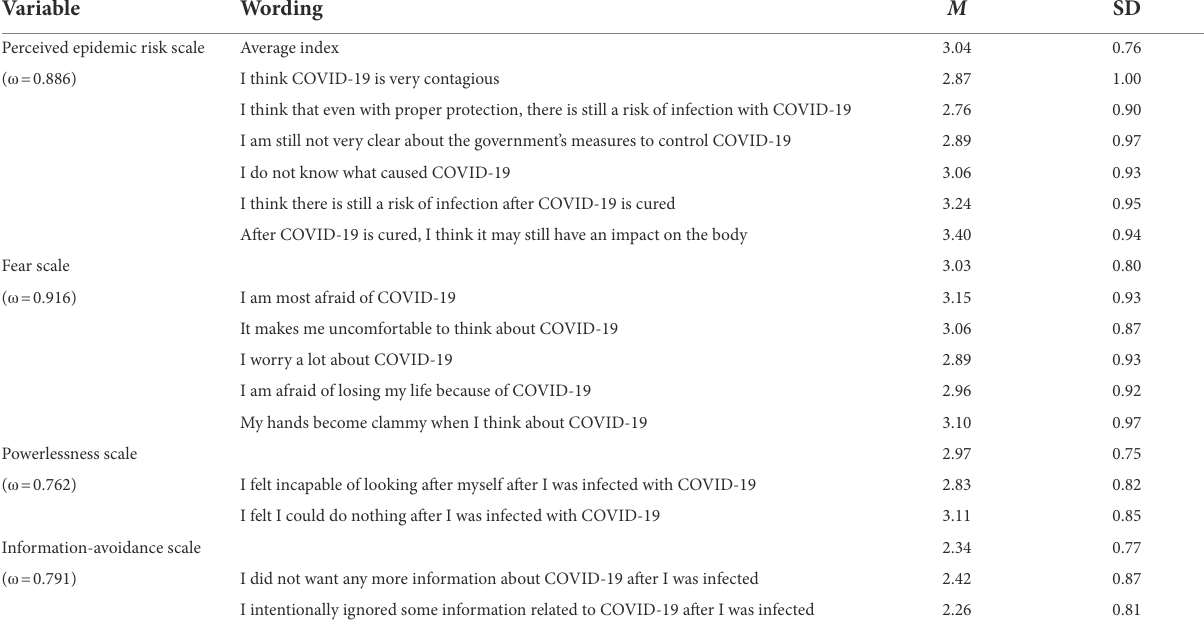
TABLE 2 Summary of the dependent, independent, and mediating variables.